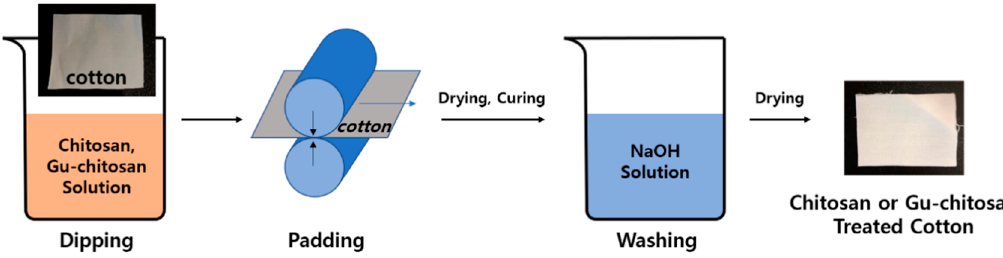
Figure 3. Schematic diagram of the preparation process of the chitosan and Gu-chitosan-treated cotton fabrics.